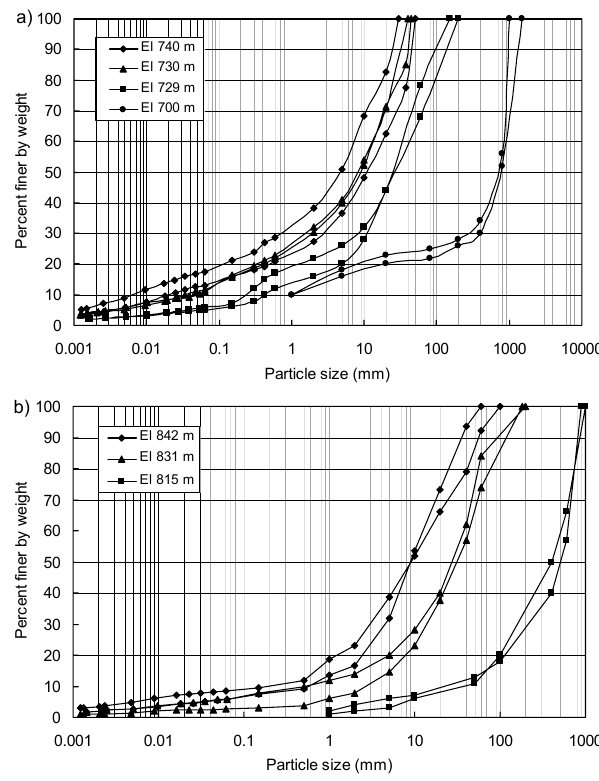
Fig. 7. Grain-size distributions for the soils at different depths. ( a ) Tangjiashan Landslide Dam; ( b ) Xiaogangjian Landslide Dam.